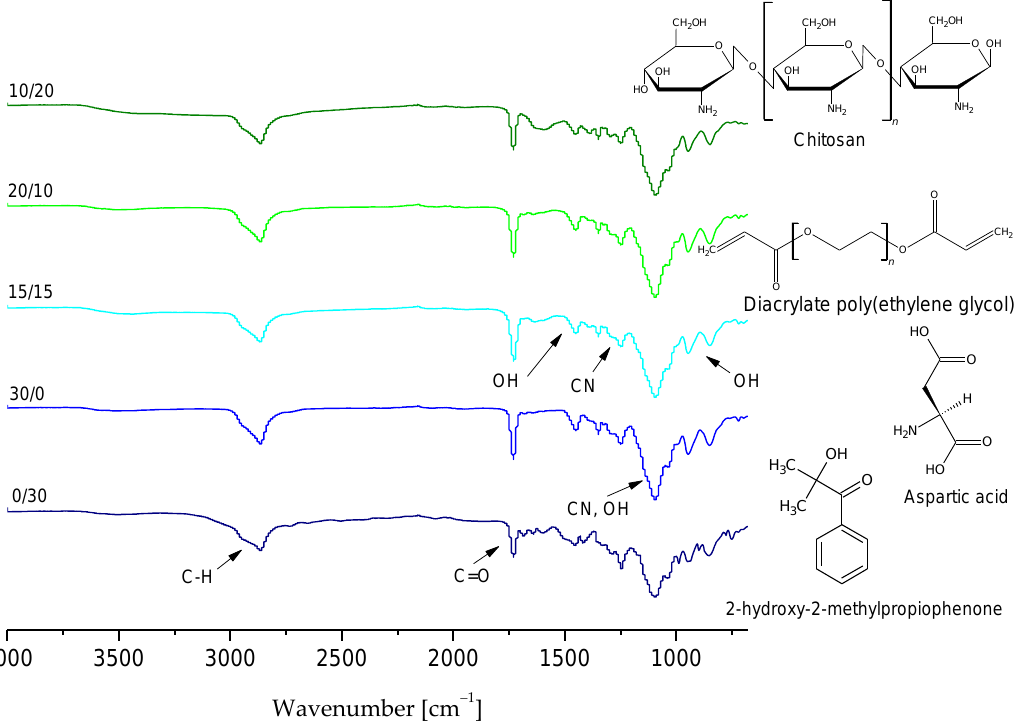
Figure 5. FT-IR spectra of chitosan/poly(aspartic acid)-based hydrogels.